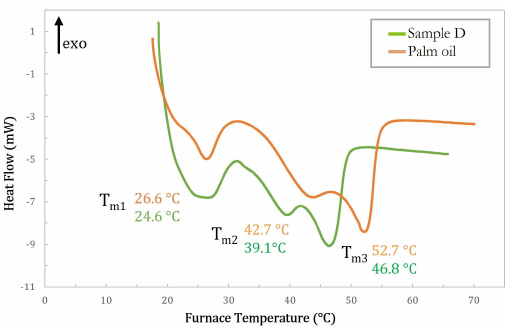
Figure 3. Melting profile of sample D (green curve) and PO (orange curve).